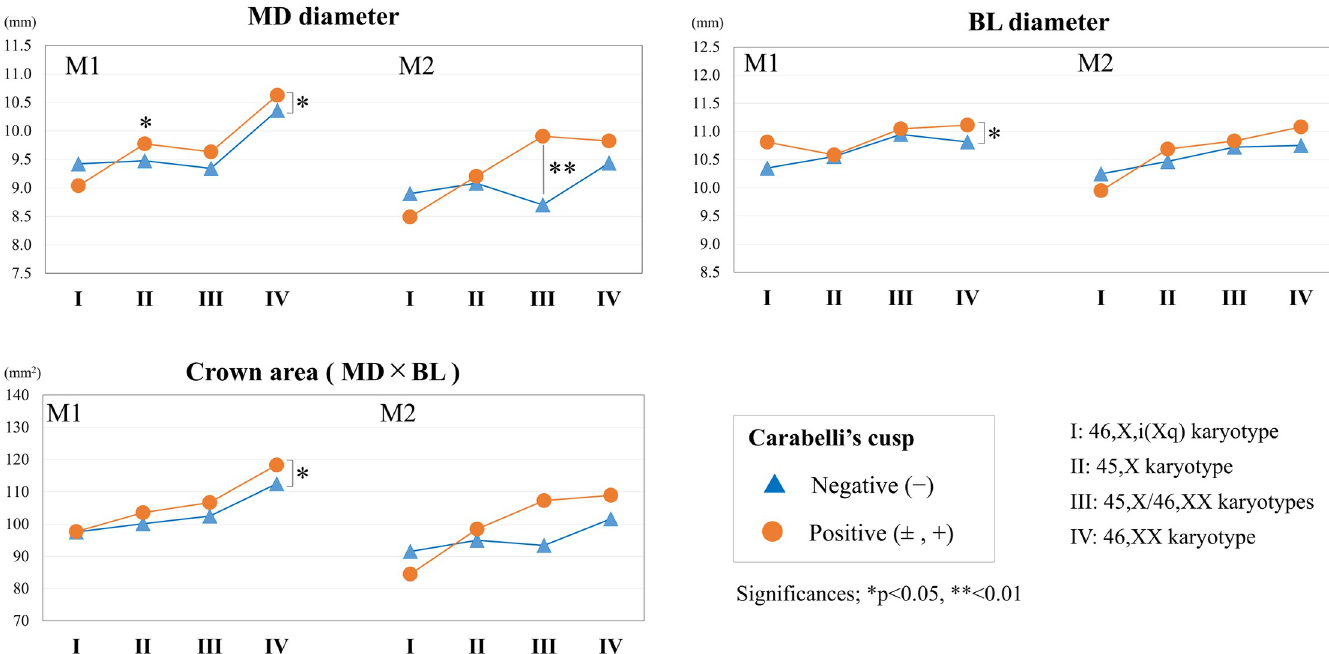
Fig 3. Mean tooth sizes (mesiodistal diameter, buccolingual diameter, crown area) and crown shape changes of Carabelli’s cusp expressions among females with Turner syndrome (46,X,i(Xq), 45,X/46,XX, and 45,X karyotypes) and population controls (46,XX karyotype). The t-test was used to assess the differences in tooth size and shape between negative and positive expression of the trait. � p < 0.05, �� p < 0.01.